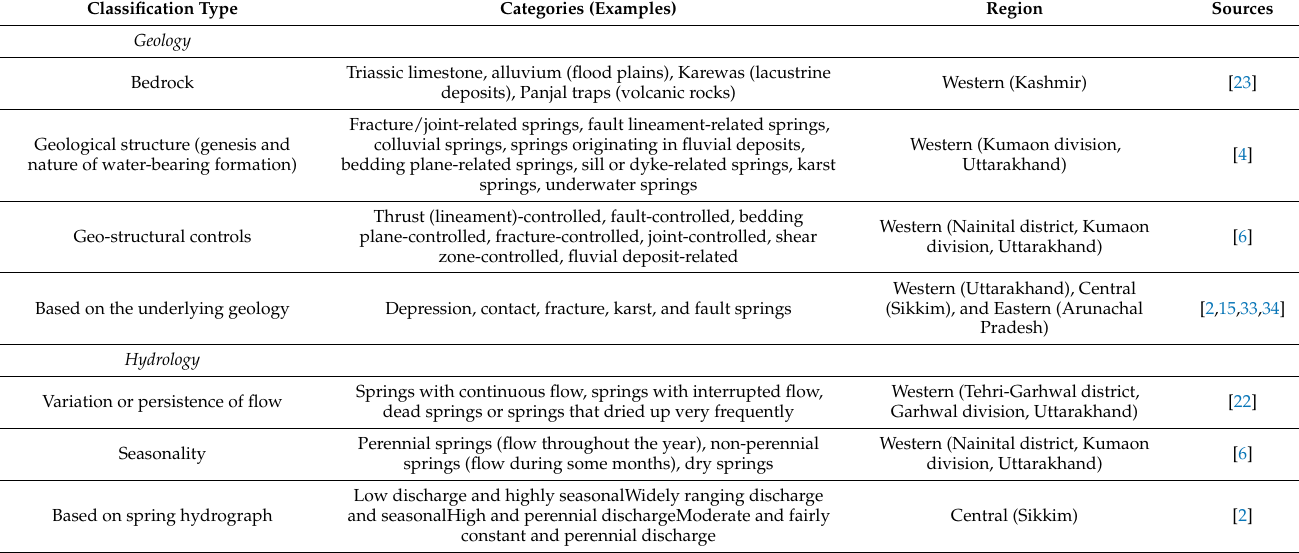
Table 1. Synthesis of typologies of Himalayan